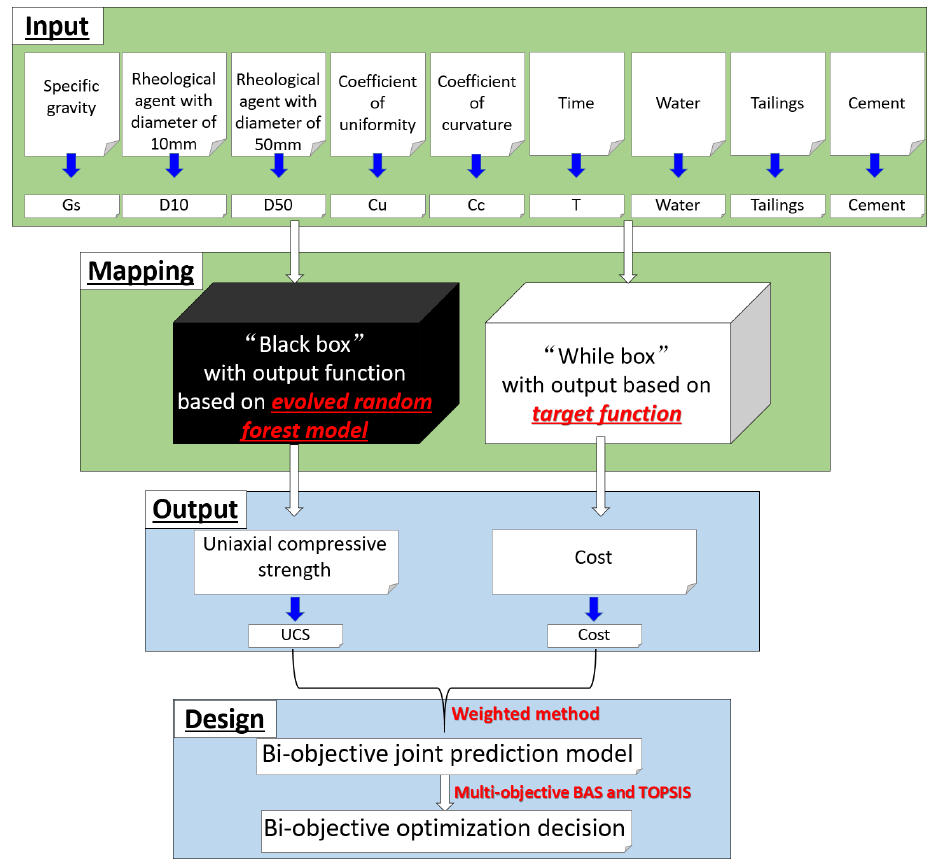
Figure 1. Research